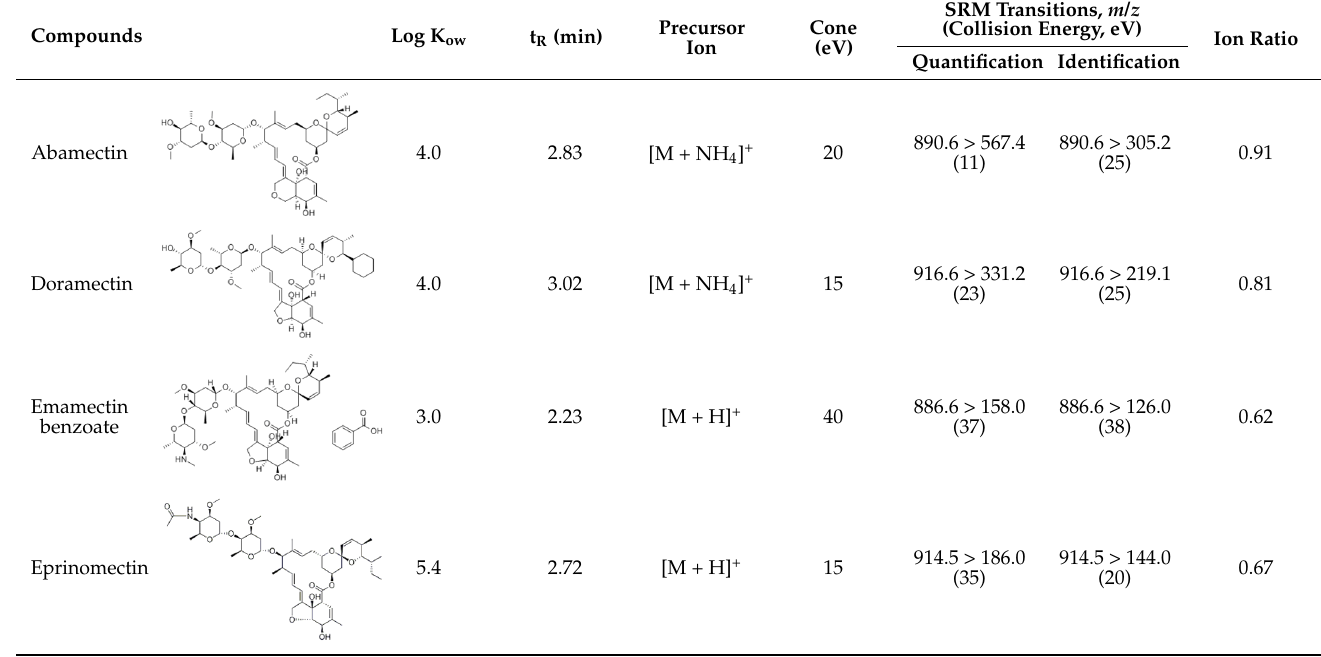
Table 1. Partition coefficients of avermectins and UHPLC parameters for the determination of their residues in soybean, bean, and maize.